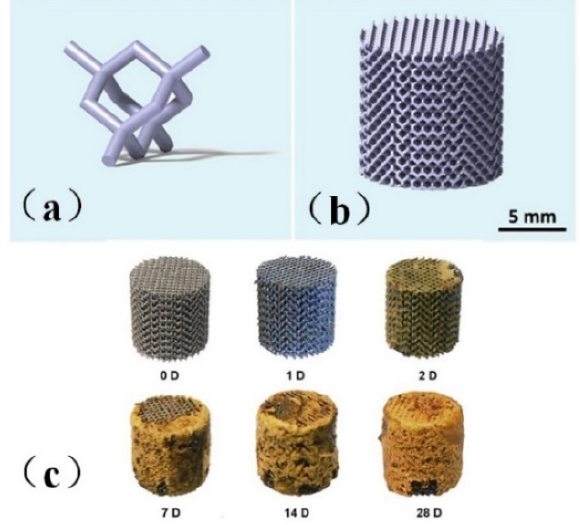
Figure 1. Model drawing of bone scaffold [48]. ( a ) unit cell structure ( b ) bone scaffold structure diagram ( c ) Bone scaffold degradation.